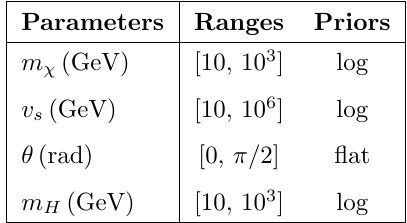
Table 1 . Ranges and priors for the free model